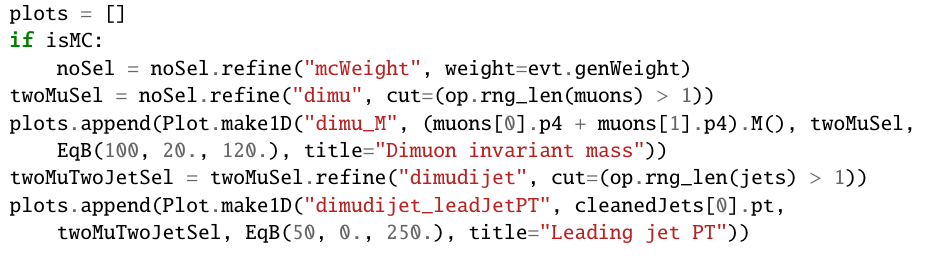
Figure 2. Example bamboo code to define Plot and Selection instances, see Section 3 for more